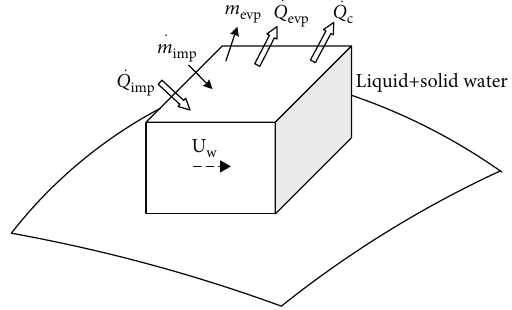
Figure 1: Mass and energy conservation of the whole water in a CV on the icing